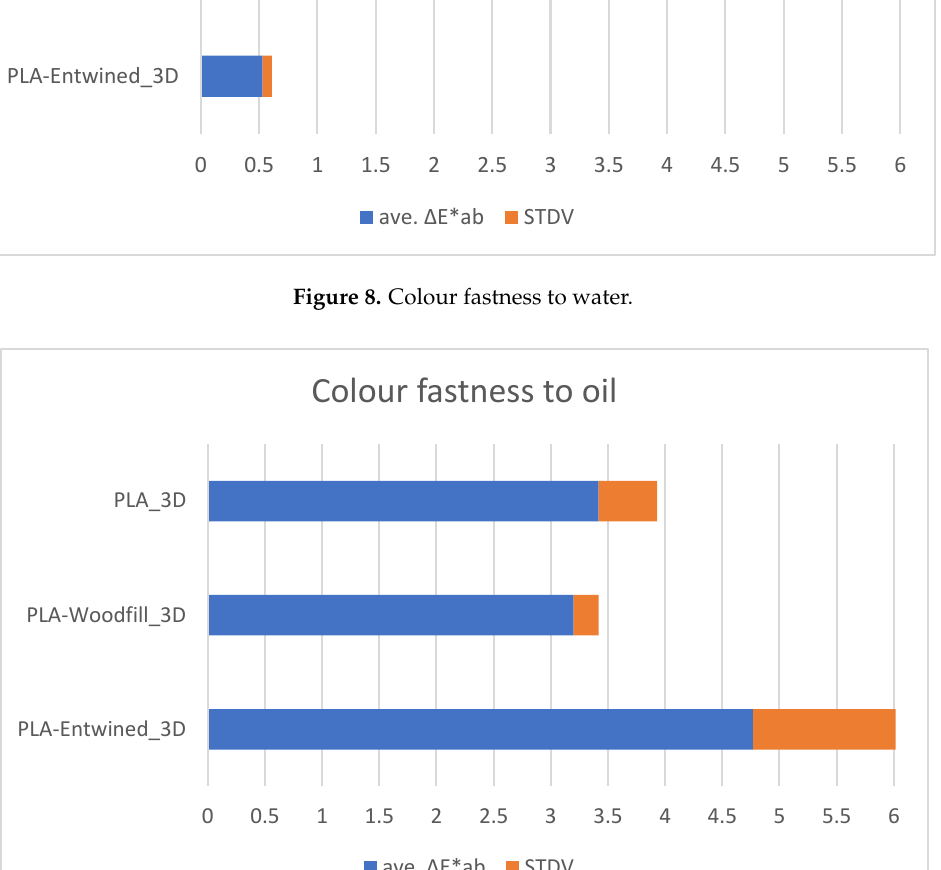
Figure 8. Colour fastness to water.